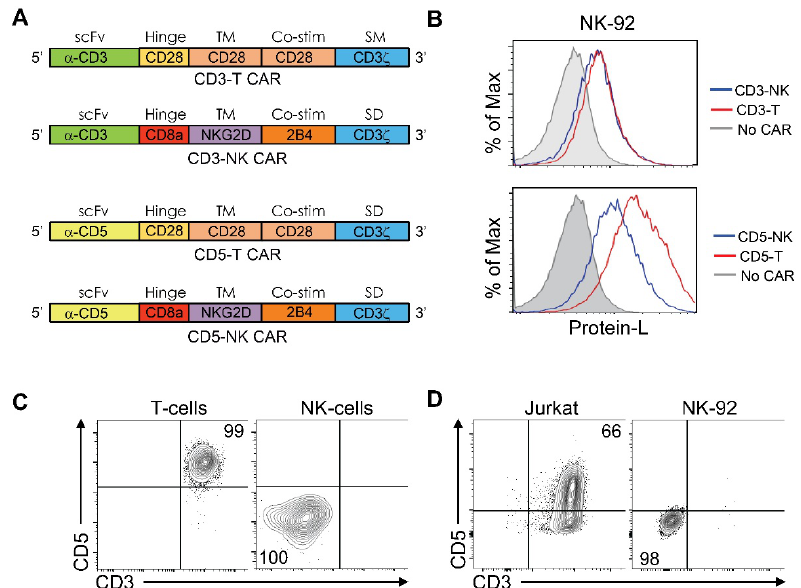
Figure 1. CARs construct design and characterization. ( A ) Schematic structure of the CD3 and CD5 CARs in a CAR-T framework (CD3-T and CD5-T) or in a CAR-NK framework (CD3-NK and CD5-NK). The identity of the different domains is represented—scFv, hinge, transmembrane (TM), co-stimulatory (Co-stim) and stimulatory (SM) domains. ( B ) FACS analysis of cell surface CAR levels in transduced NK-92 cells stained with Protein-L. ( C ) FACS analysis of target molecules on primary cells. T cells correspond to CD3+ and NK cells correspond to CD56+ PBMCs from healthy donors. ( D ) FACS analysis of target molecules on cell lines. Data are representative of two independent experiments.